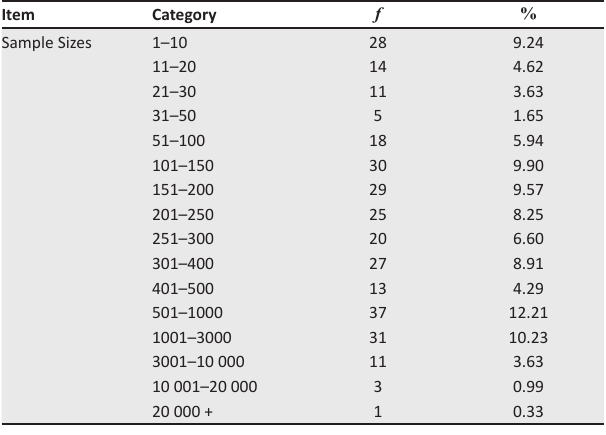
TABLE 7: Sample sizes utilised in the publications.